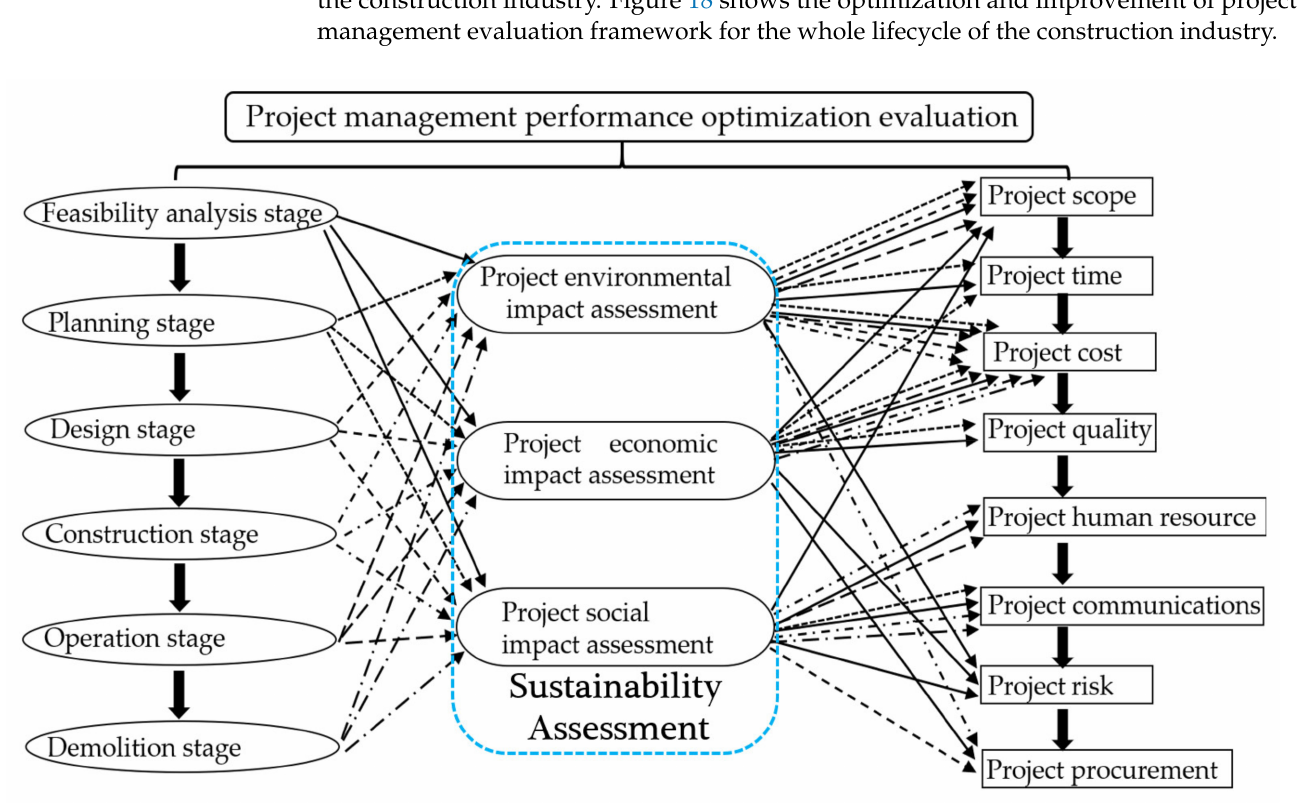
Figure 18. Optimized sustainable development project management evaluation framework